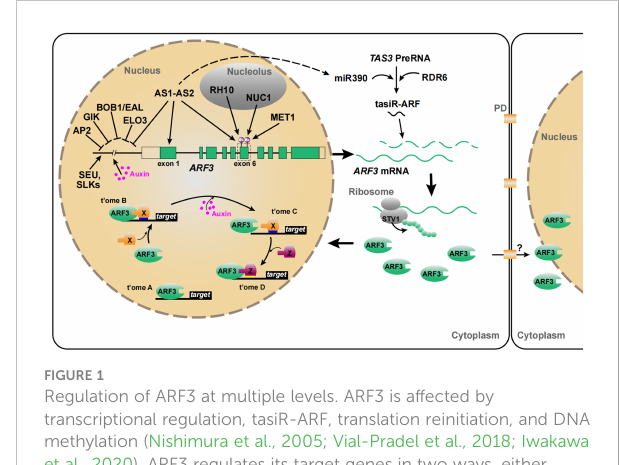
FIGURE 1 Regulation of ARF3 at multiple levels. ARF3 is affected by transcriptional regulation, tasiR-ARF, translation reinitiation, and DNA methylation (Nishimura et al., 2005; Vial-Pradel et al., 2018; Iwakawa et al., 2020). ARF3 regulates its target genes in two ways, either dependent on auxin or independent of auxin (Simonini et al., 2017). ARF3 can also migrate intercellularly (Zhang et al., 2022). The ARF3 gene, mRNA, and protein are in green. Auxin is in magenta. t ’ ome A/ B/C/D, transcriptome A/B/C/D. “ X ” and “ Z ” , the partners of ARF3. PD, plasmodesmata (Whether ARF3 travels from cell to cell via PD remains to be con fi